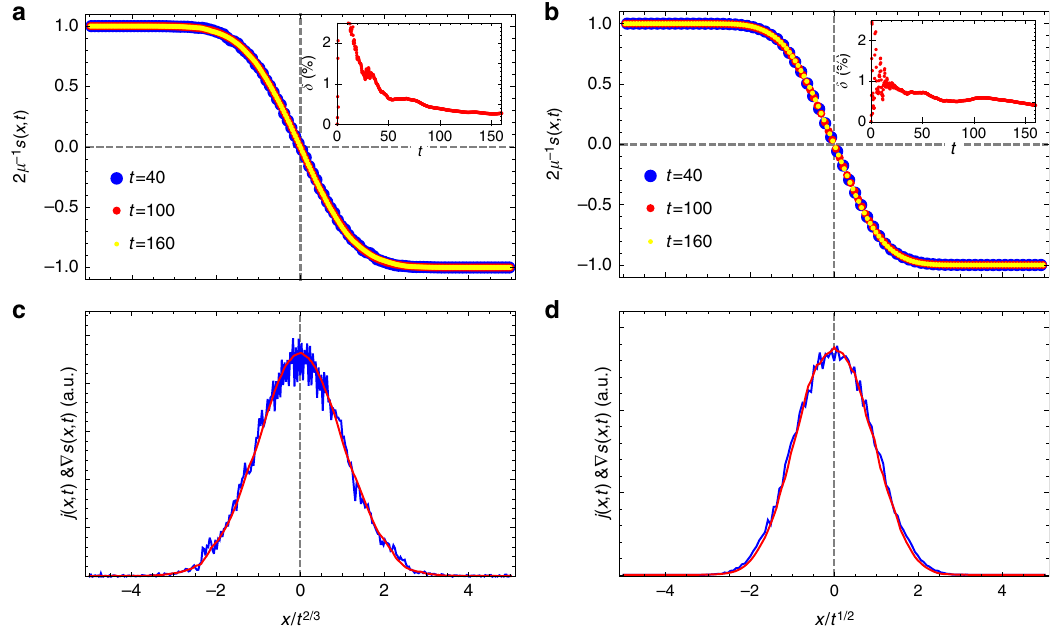
Figure 3 | Scaling profiles. Scaling of density and current profiles with x / t a . In ( a , b ) we show the scaling of magnetization profiles, ( a ) for D ¼ 1 using a ¼ 2/3, and ( b ) for D ¼ 2 and using a ¼ 1/2 (note that the points for different times overlap almost perfectly; the insets show the convergence of the relative root-mean-square difference (in %) between data s ( x , t ) and scaled erf-profiles (see text) as a function of time). Frames ( c , d ) show the emergence of Fick’s law at late times (shown at t ¼ 160), comparing current profiles (red) to gradients of spin density (blue)—both indistinguishable from Gaussians, for D ¼ 1 in ( c ) and D ¼ 2 in ( d ). In all plots the system size is n ¼ 320.